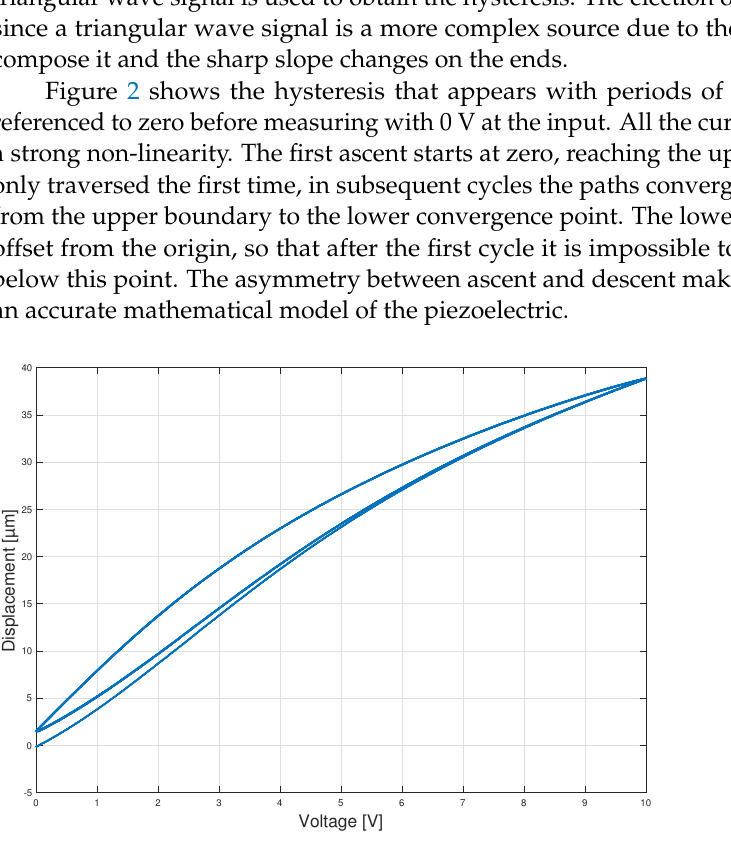
Figure 2. Hysteresis graph description of the commercial Piezoelectric Actuator